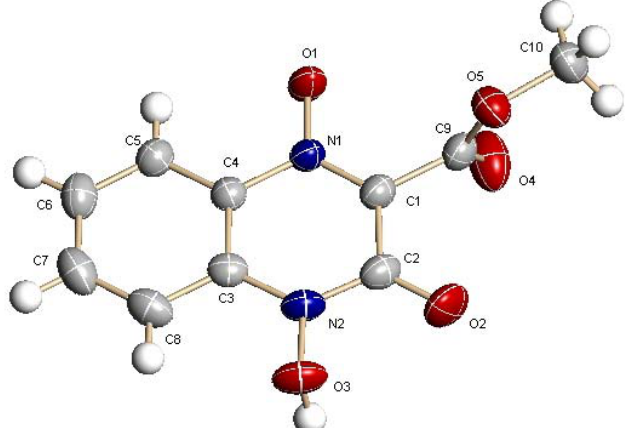
Figure 1. X-Ray crystal structure of 1